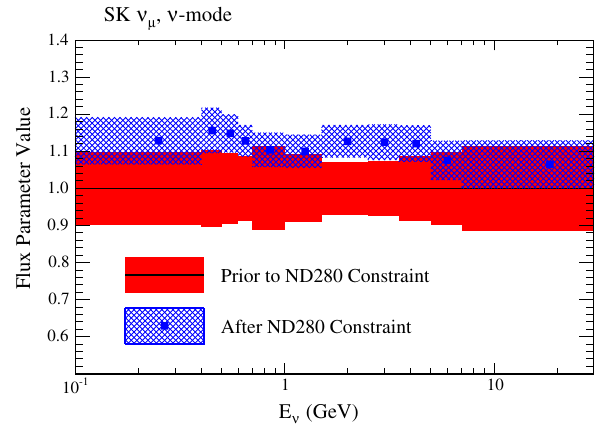
Fig. 61 The fitted ν μ flux parameters at SK in neutrino mode. The values of the parameters are set to 1 in the simulation before tuning. The values are used as a weight to the predicted flux